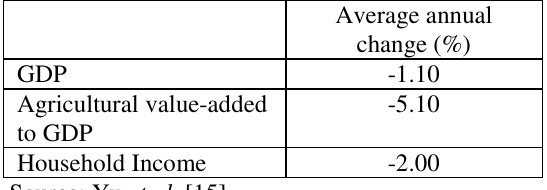
percent, attributed to climate change. Table 3: Projected Climate Change Impacts in Pakistan